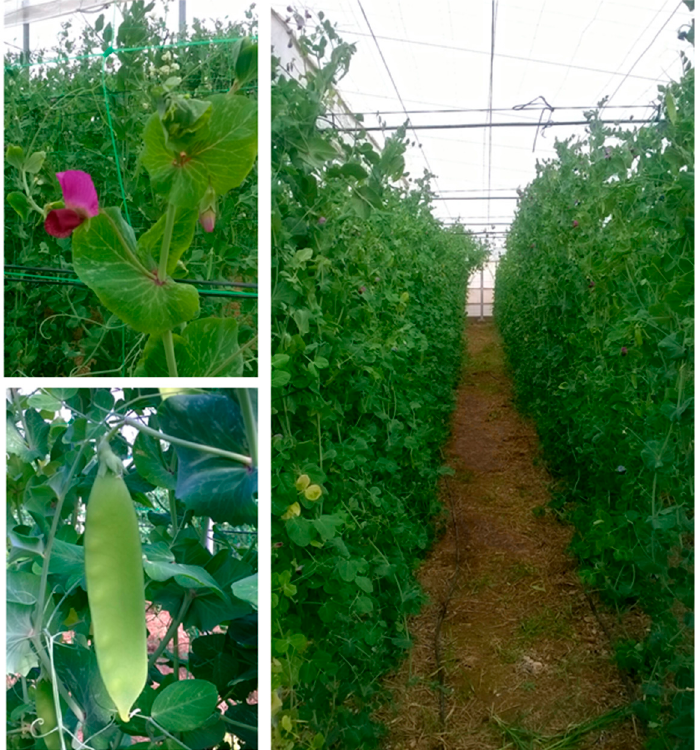
Figure 2. Detail of flower, leaves ( left up ) and pod ( left down ) of mangetout. Panoramic view of field trial ( right ). Table 1. Cultivars, companies and growth habit of mangetout used in this study.